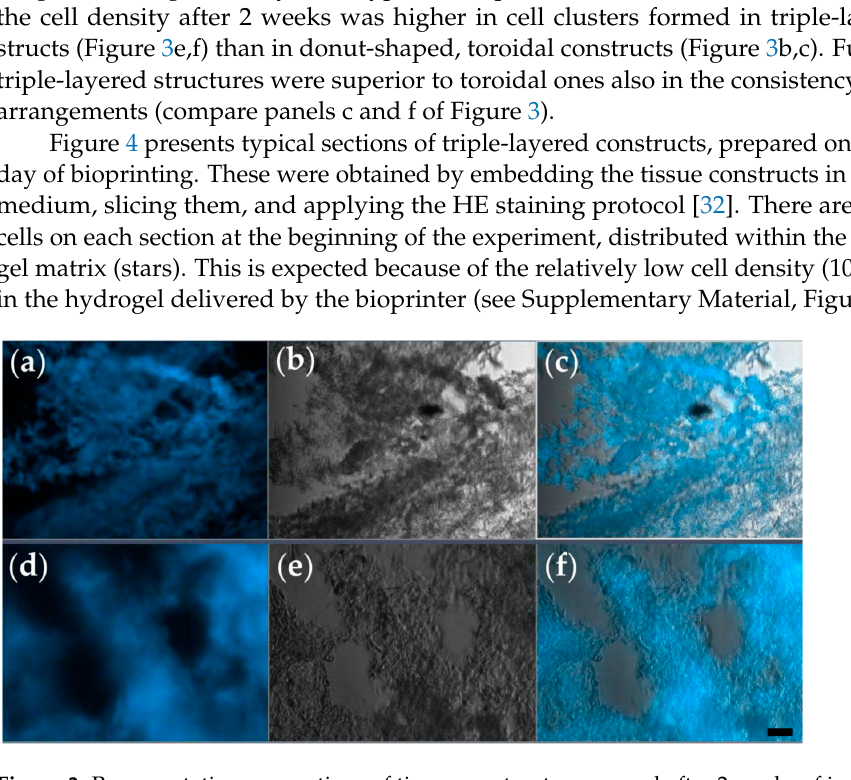
Figure 3. Representative cryosections of tissue constructs, prepared after 2 weeks of in vitro culture. ( a – c ) Section of the toroidal tissue construct; ( d – f ) section of the triple-layered tissue construct. Each section is visualized as a fluorescence microscopy image obtained via Hoechst staining ( a , d ), bright-field microscopy ( b , e ), and their overlay ( c , f ); (ob. 10×); scale bar = 10 µm.